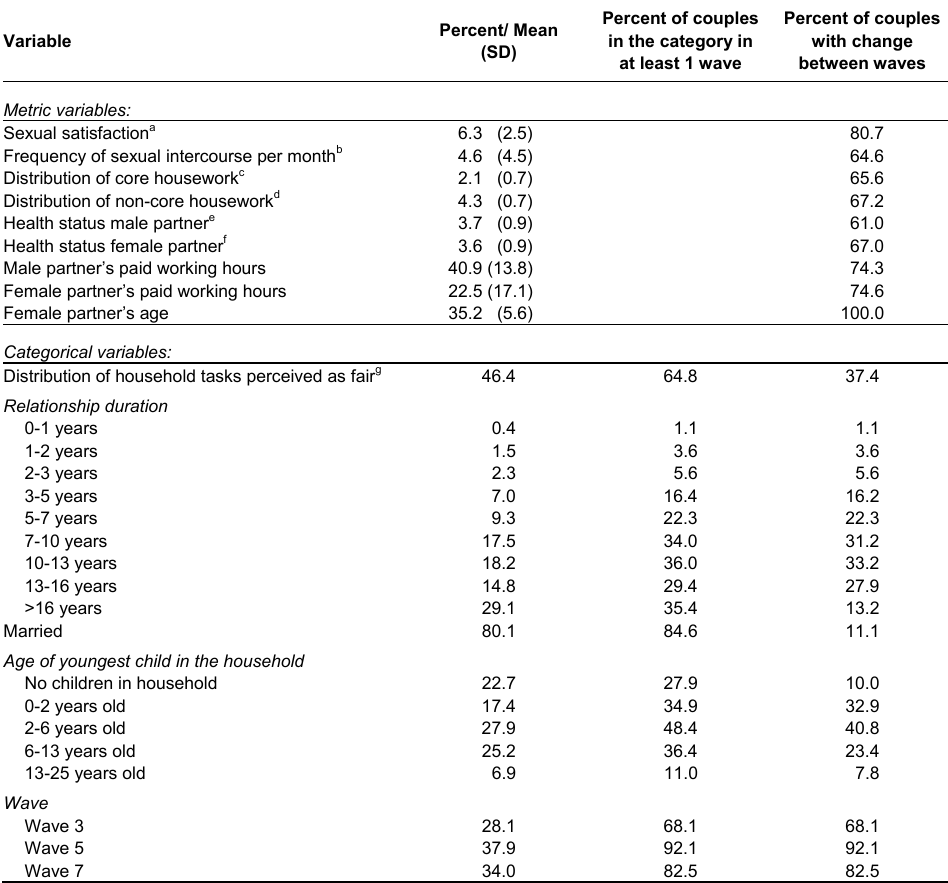
Percent of couples Percent of couples Percent/ Mean in the category in with change (SD) at least 1 wave between waves